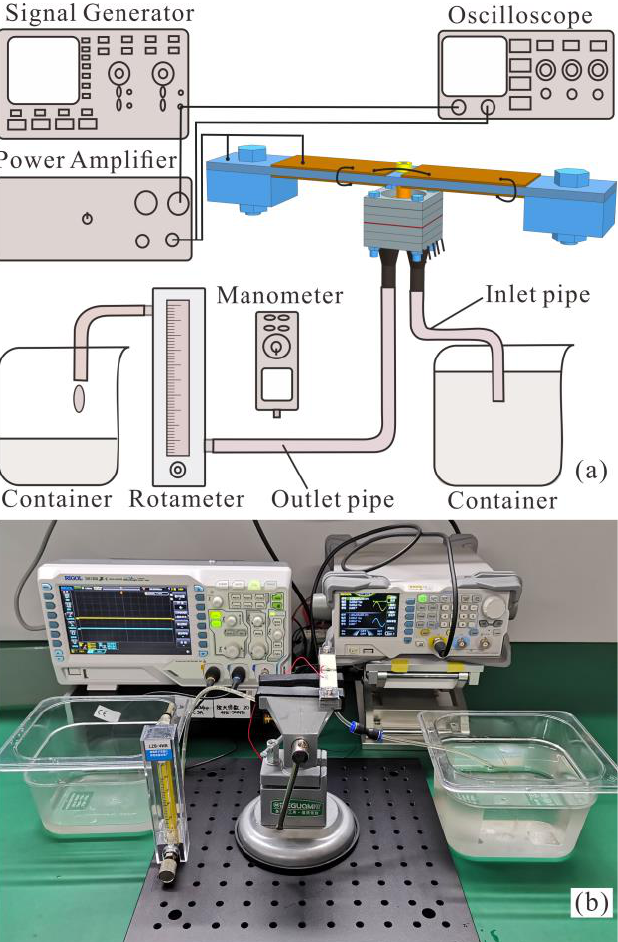
Figure 11. ( a ) Schematic illustration and ( b ) photograph of the experimental